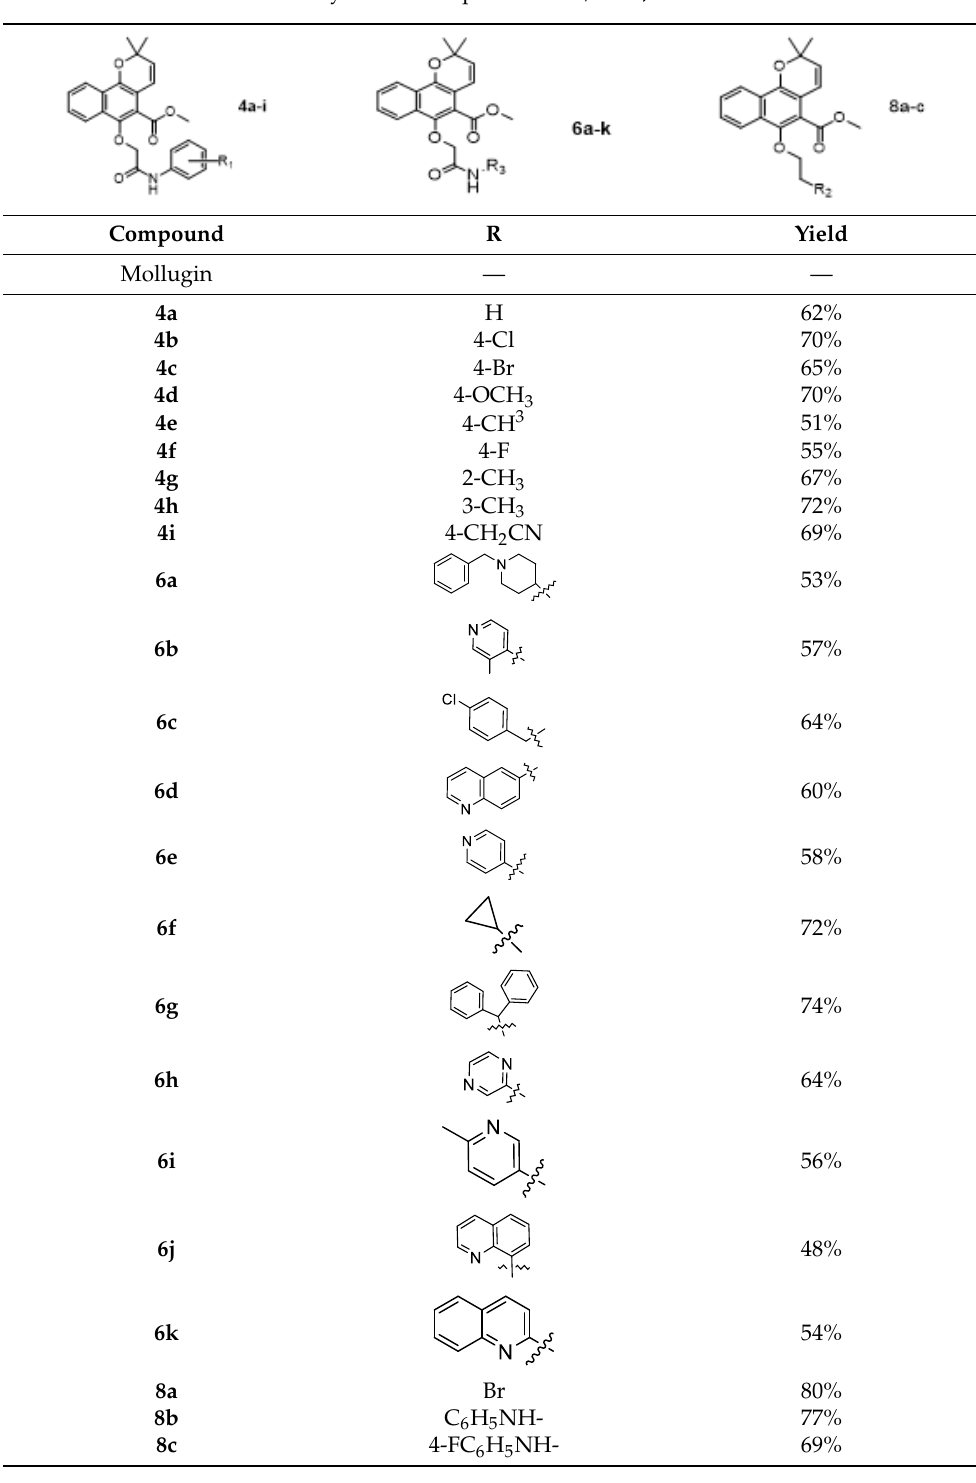
Table 8. Structural formulas and yields of compounds 4a-i , 6a-k, and 8a-c.